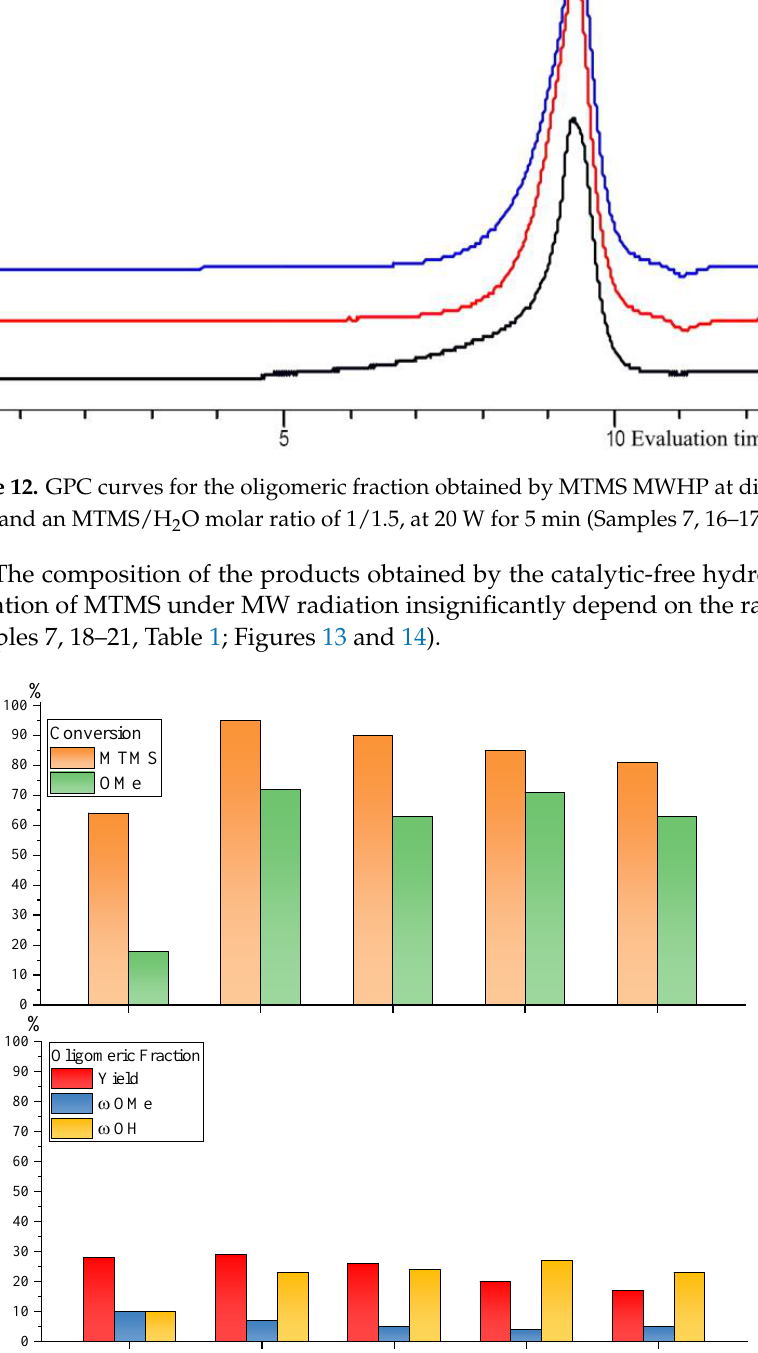
Figure 13. Diagrams of monomer and MeO-group conversions ( A ) and of the yield, MeO- and OH-group contents in the oligomeric fractions obtained by MWHP of MTMS ( B ) at different radiation powers and an MTMS/H 2 O molar ratio of 1/1.5, at 30 ◦ C for 5 min (Samples 7, 18–21, Table